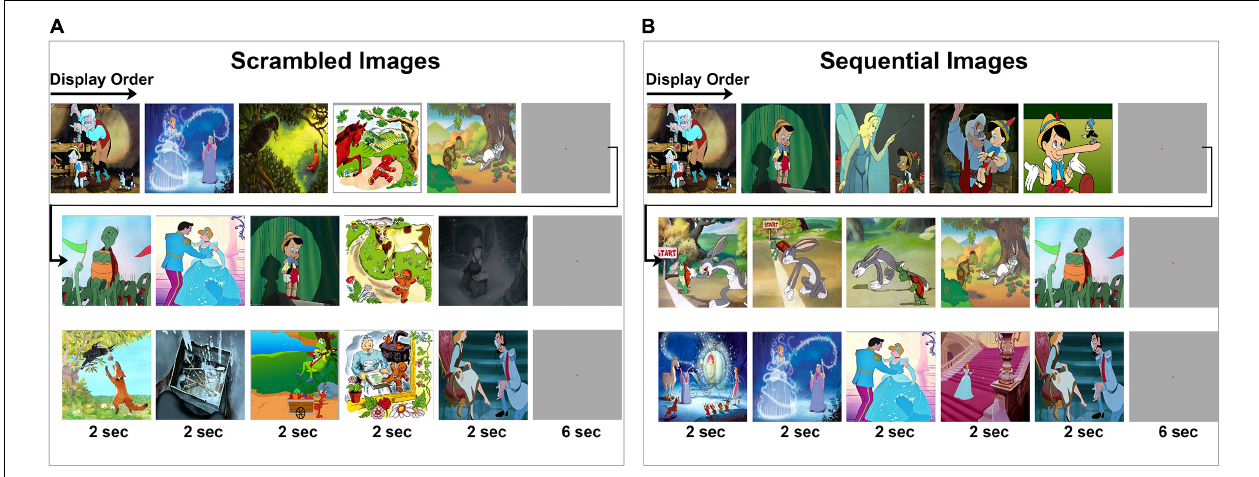
FIGURE 1 | Visual experiment design. Subjects viewed a series of cartoon images that are part of five fables under two experimental conditions. Displayed is a subset of the image sequences. Within each row, the chronological order of image presentation is from left to right as indicated by the arrow. (A,B) A total of seven image series were presented where each series consisted of five images presented for 2 s each, followed by a gray screen for 6 s duration before the start of the next image series. The full set of images are provided in Supplementary Figures 1 , 2 . (A) Subjects were first instructed to fixate at the center of the screen while a series of images are presented in scrambled order. (B) Then, subjects were instructed to fixate at the center of the screen while the same images are presented in a sequential